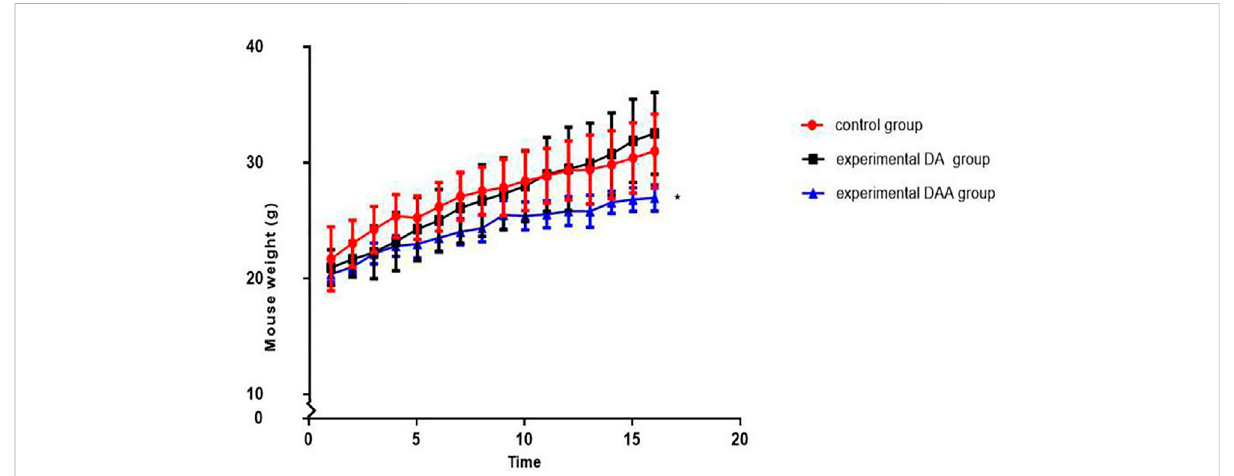
FIGURE 1 Effectsonweightinmice.Themicewereweighedtwiceaweek(1/2 weeksinterval)for8 weeks.ThemeanweightofthemiceintheDAAgroup was signi fi cantly lower than that of the mice in the other two groups. However, the mice in each group did not lose weight signi fi cantly, re fl ecting their good health condition. * indicates p <